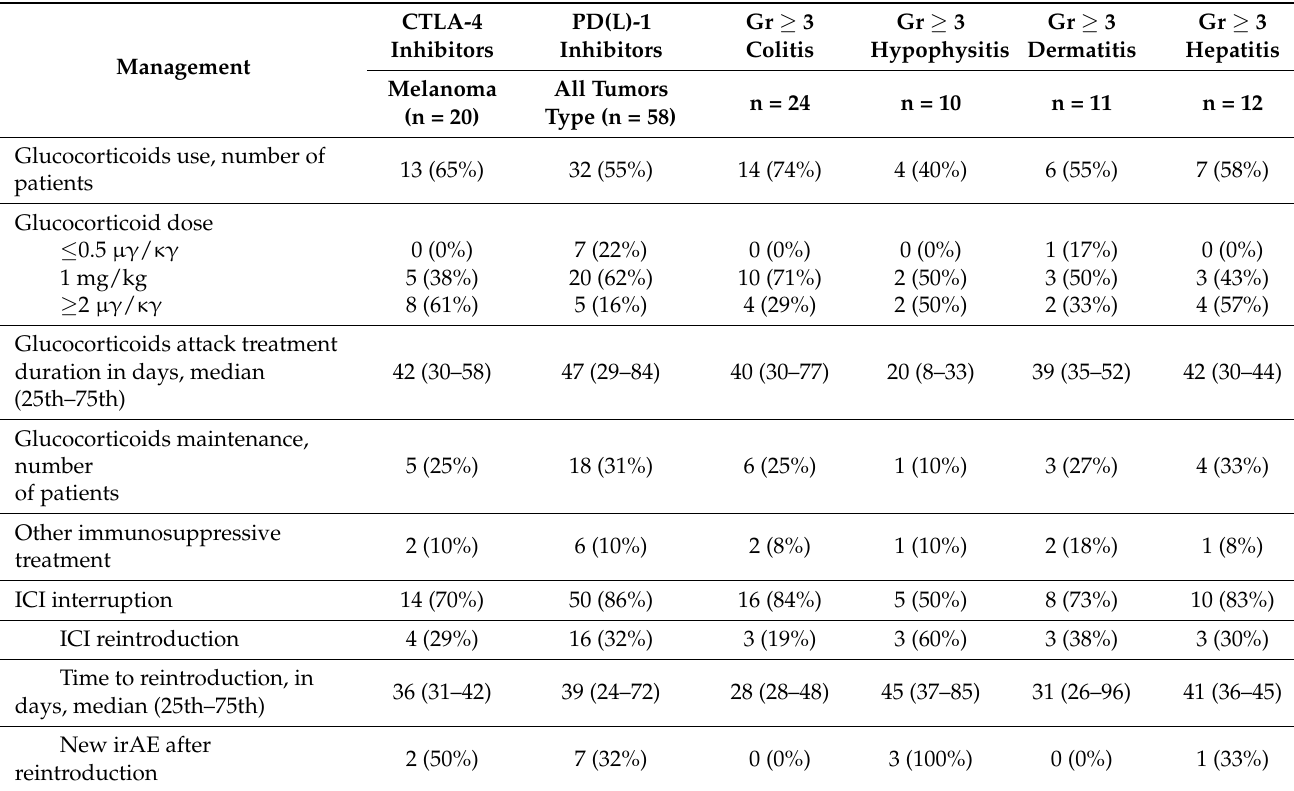
Table 3. Management of grade ≥ 3 irAEs. irAEs = immune-related Adverse Events; ICI = immune check-point inhibitors.